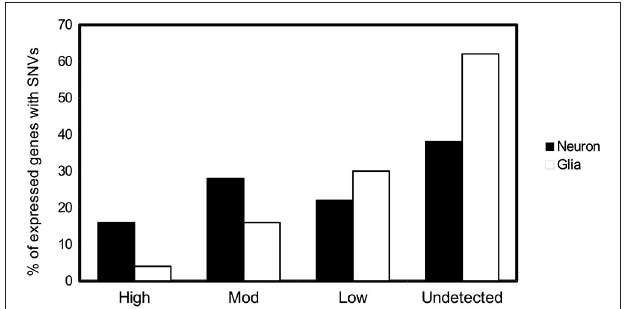
FIGURE 2 | SNVs in neuron and glia . Possible relationship with DNA transcription or DNA replication. Percentage of genes with at least one SNV expressed in hippocampal neuron and glial cells (Parcerisas et al., 2014) that are translated into proteins according to the expression levels provided by the database The Human Protein Atlas . 1 The levels of expression of the first 200 genes containing the most hippocampal-specific SNVs (according to a Fisher test respect to the SNVs found in blood), as shown by immunological detection, were checked one by one in the database and their expression in this tissue was